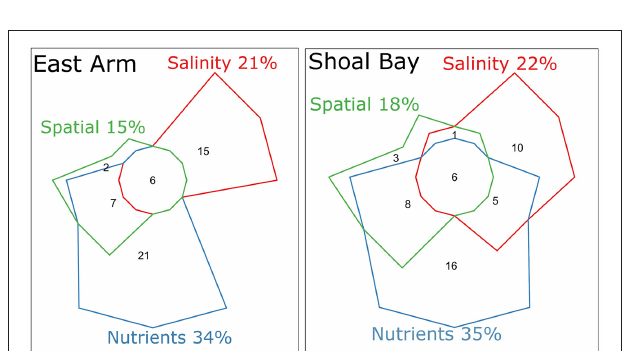
FIGURE 4 | Variation partitioning of the water microbiota at neap tide from East Arm and Shoal Bay. The numbers indicate percentage of the microbiota variation explained by the corresponding fraction or combination thereof. Percentages are based on the adjusted R 2 accounting for the number of other predictors. Nutrients and salinity were standardized to the same scale. The forward selected nutrients explaining significant parts of the microbiota in a redundancy analysis included PO 3 − 4 , NH + 4 , NO 3 , NO 2 , DOC, and TOC for East Arm and TP, TDP, PO 3 − 4 , TDN, NH + 4 , NO 3 , NO 2 , DOC for Shoal Bay. The spatial fraction consisted of the PCNM eigenvectors. The fraction shared between salinity and nutrients was minus 3.6% for East Arm and assumed zero. The residual unexplained fraction for East Arm was 52.6 and 50.8% for Shoal